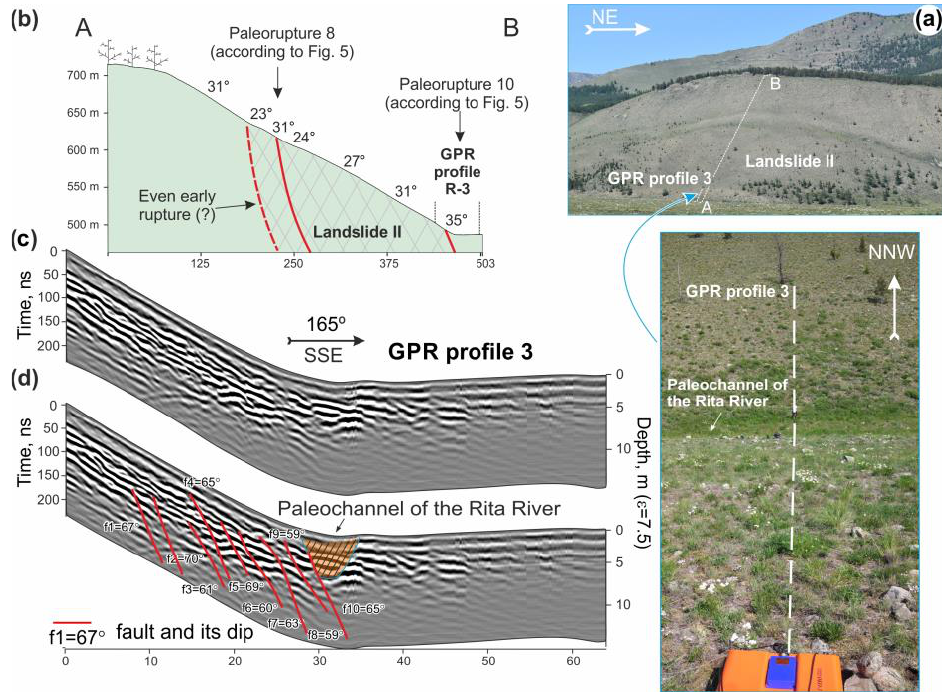
Figure 12. GPR profile 3 across the fault scarp (rupture 10, see location in Figures 4 and 5): ( a ) lo- cation of GPR line at the base of landslide II; ( b ) topographic profile A–B across the landslide II; ( c ) radargram; ( d ) its interpretation with inferred ruptures and paleochannel.